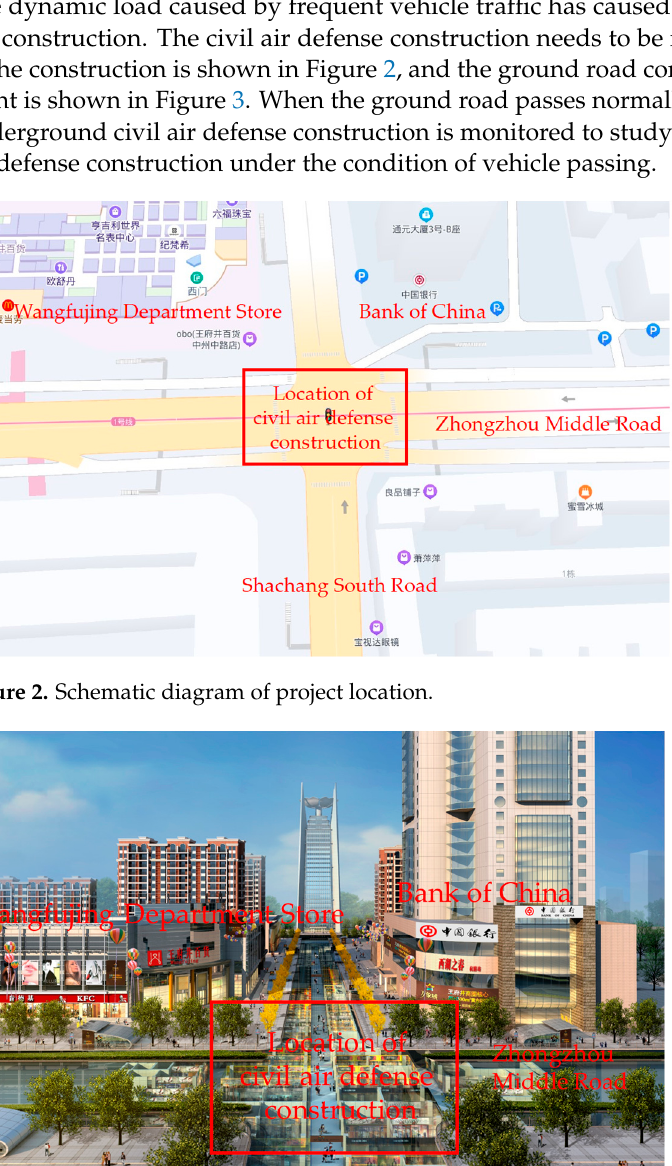
5 of 24 Figure 1. Flow chart of grey correlation analysis.